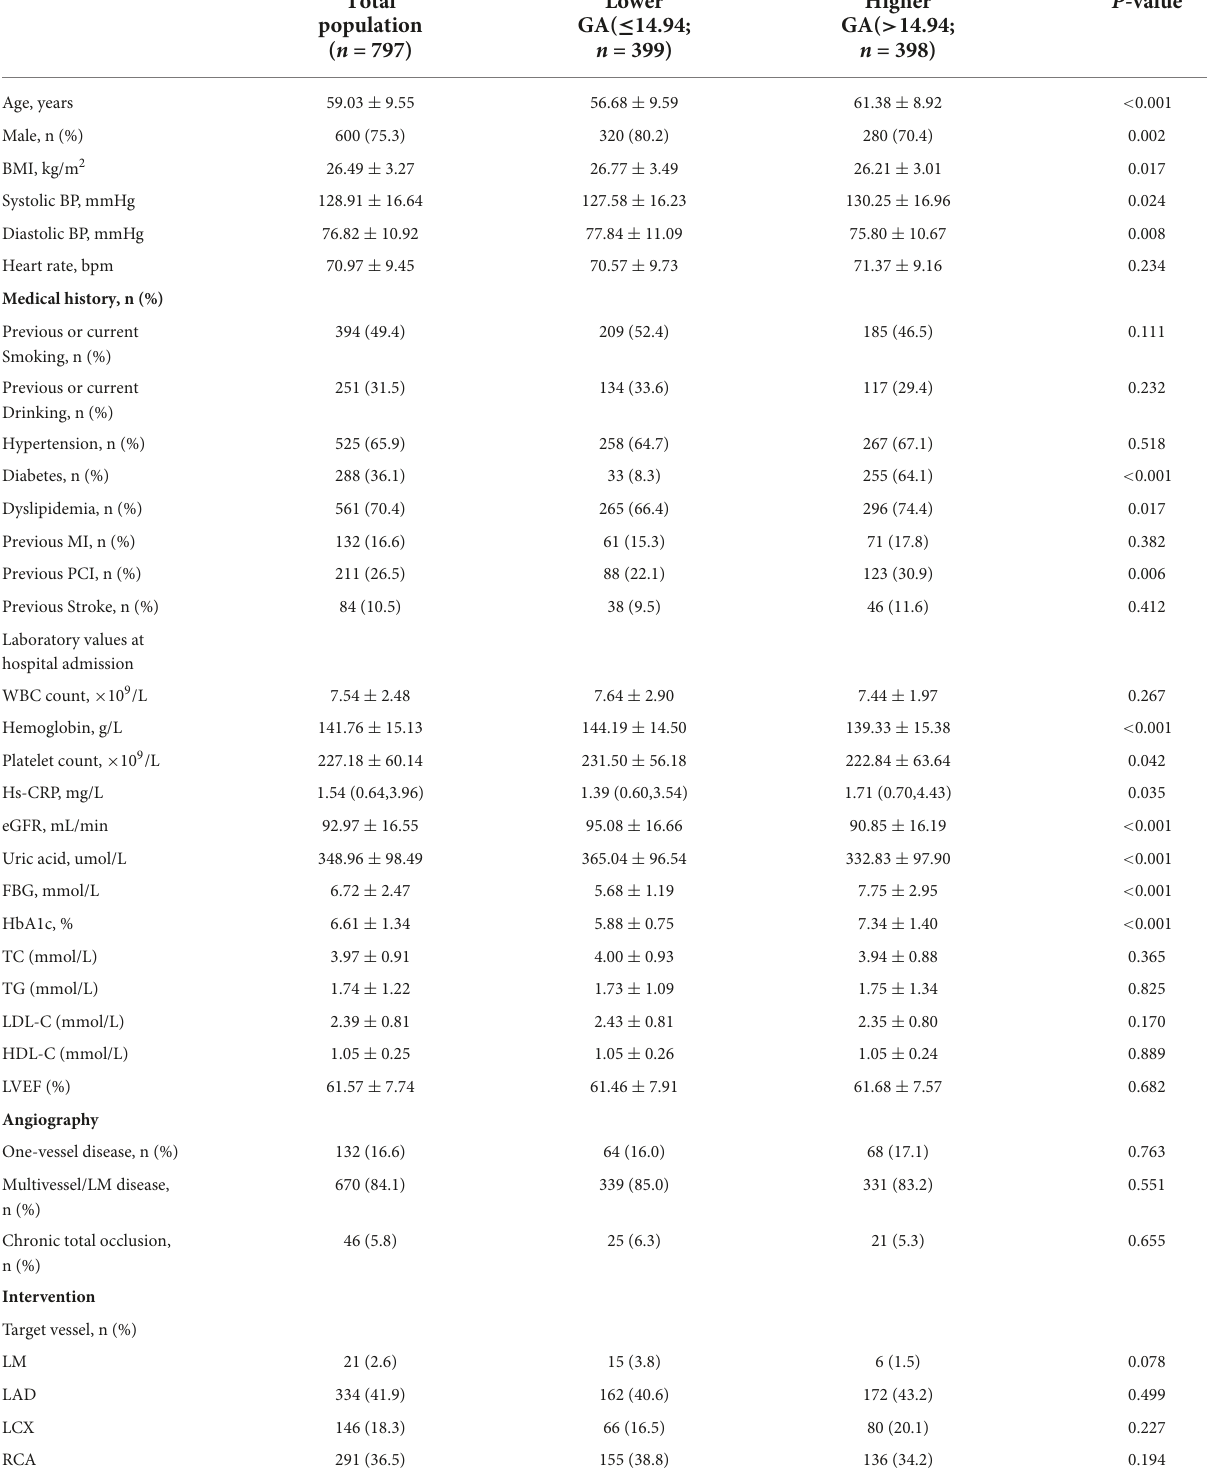
TABLE 1 Baseline characteristics of the study